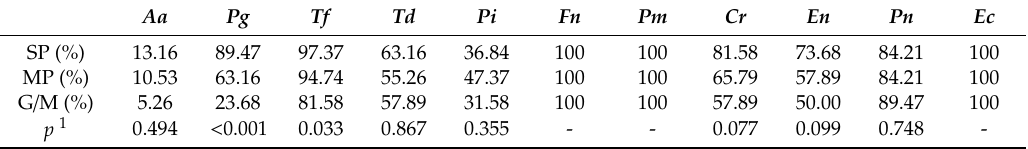
Table 4. Prevalence of target bacteria in mouthwash samples of di ff erent study